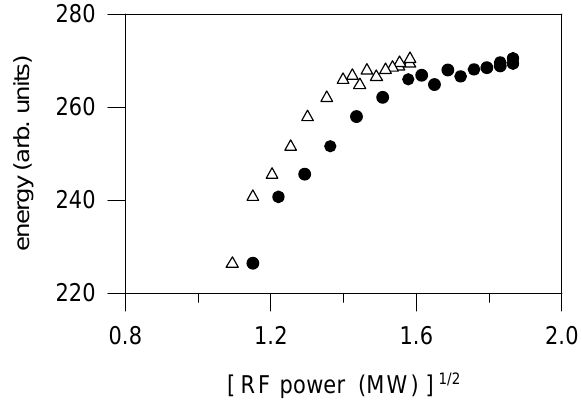
FIG. 6. Dark current energy (centroid of the distribution) as a function of the square root of the input RF power. The circles refer to the forward input power and the triangles correspond to the difference between forward and reflected power.